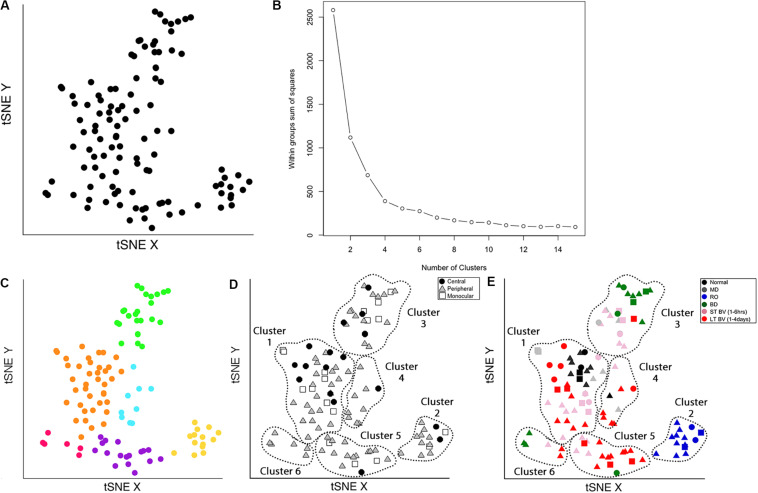
Identifying clusters from plasticity phenotypes using t-Distributed Stochastic Neighbor Embedding (t-SNE) and k-means clustering. (A) An XY representation of tSNE transformed data. (B) The optimal number of clusters was chosen by measuring the within-groups sum of squares, and selecting the inflection point (k = 6). (C) The six clusters are represented as different colored dots. (D) The content of each cluster was visualized for the three cortical regions (central, peripheral, monocular) and (E) six rearing conditions (normal, MD, RO, BD, ST-BV, LT-BV). Panels (C–E) reproduced from Balsor et al. (2019b), used with permission.